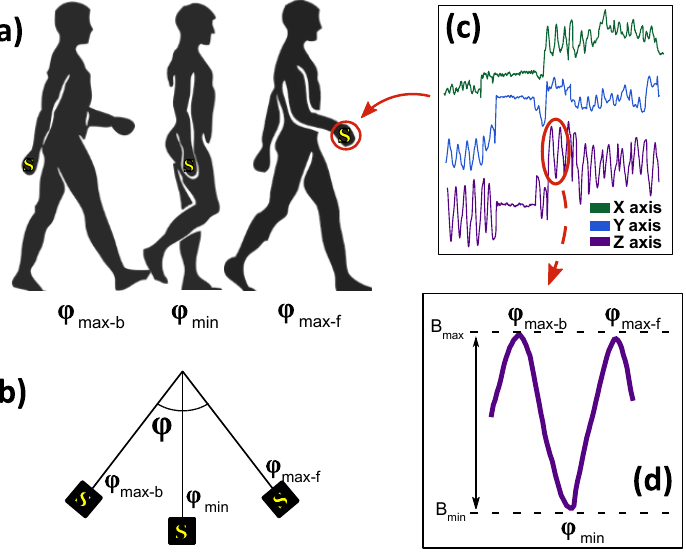
Figure 1. Concept of step detection based on measurement of magnetic field variation caused by natural arm swing during walking. Position of sensor on the arm ( a ). The arm as a pendulum-like motion ( b ). Example of magnetic field measured by the sensor during walking ( c ). Periodically changing magnetic field caused by the arm swing during walking ( d ).